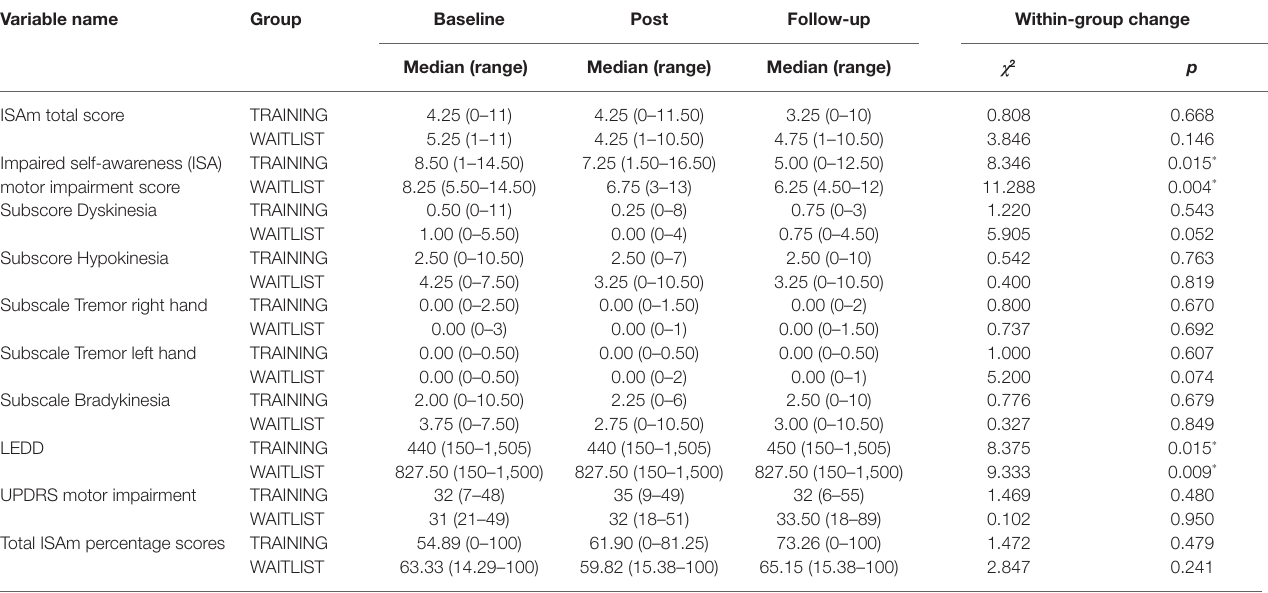
TABLE 5 | Absolute values for ISAm total and subscale scores, total ISAm percentage scores, levodopa equivalent daily dose, and motor symptom severity for all measurement points. Variable name Group